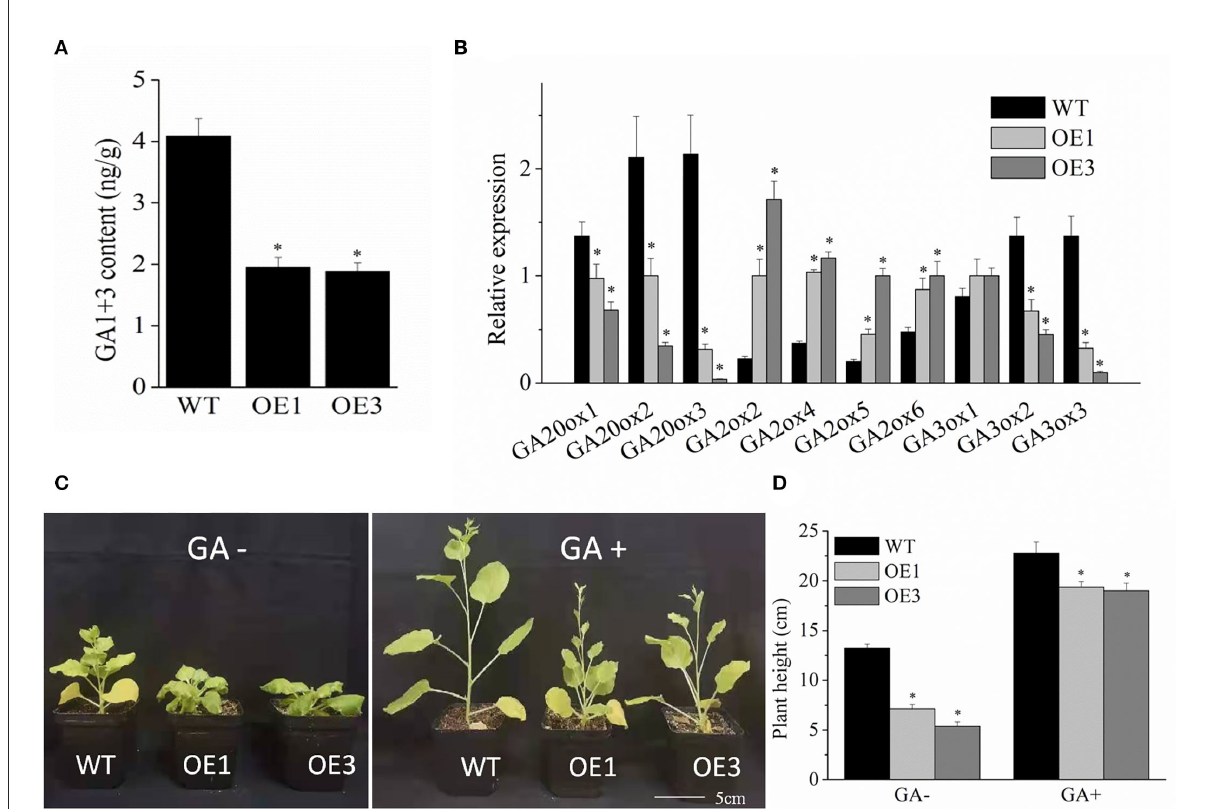
FIGURE4 The VyMYB24 gene regulated GA biosynthesis in the transgenic lines. (A) The content of GA1 + 3 was measured by the ELISA method. (B) Expression profiles of the GA biosynthesis-related genes. (C) Phenotypic characteristics of the transgenic lines and wild-type plants were sprayed with 10 − 5 M GA after three weeks, and the plant height was measured (D) . Bars represent mean ± SD. A significant difference from the WT was confirmed by a one-way ANOVA test, * p <